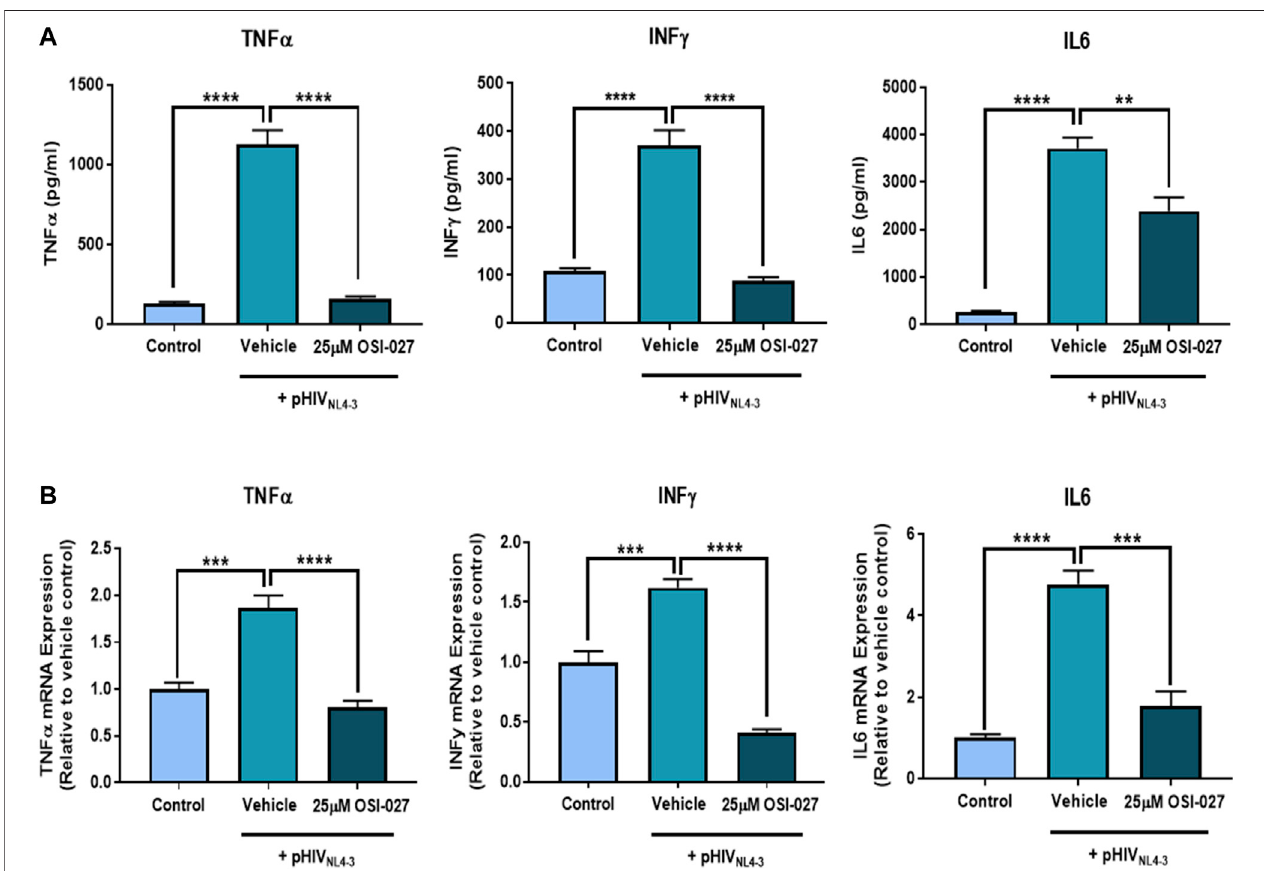
FIGURE 5 | The effects of mTOR inhibitor OSI-027 on the expression and secretion of proin fl ammatory cytokines from pHIV NL4-3 exposed PBMCs. PBMCs and supernatants were collected following exposure to vehicle, pHIV NL4-3 only, or pHIV NL4-3 in the presence of 25 µM OSI-027 for 48 h. (A) cytokine concentrations in cell culture supernatants; results are expressed as mean ± SEM ( n (cid:2) 3 donors). (B) Cytokine mRNA levels were measured using qPCR. GAPDH was used as the housekeeping gene. Results are expressed as mean ± SD ( n (cid:2) 3 donors). Asterisks represent data points signi fi cantly different from cells exposed to HIV only. Multiple comparisons were performed using one-way ANOVA and Bonferroni ’ s post-hoc analysis; p < 0.05 was considered statistically signi fi cant. **, p < 0.01; ***, p < 0.001; ****, p < 0.0001.